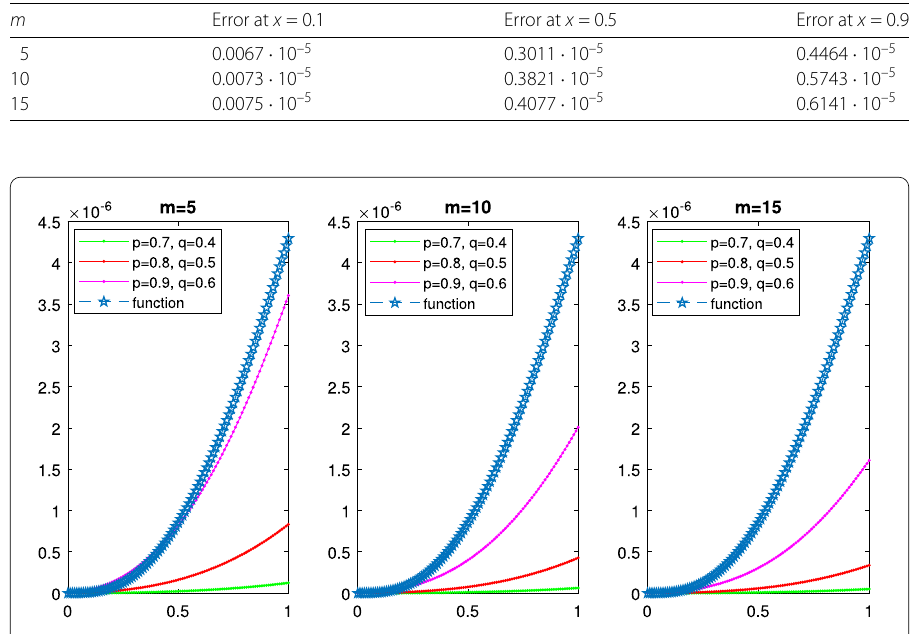
Figure 2 Convergence of the ( p , q )-analogue Lupa¸s–Schurer operators L p , q values of p and